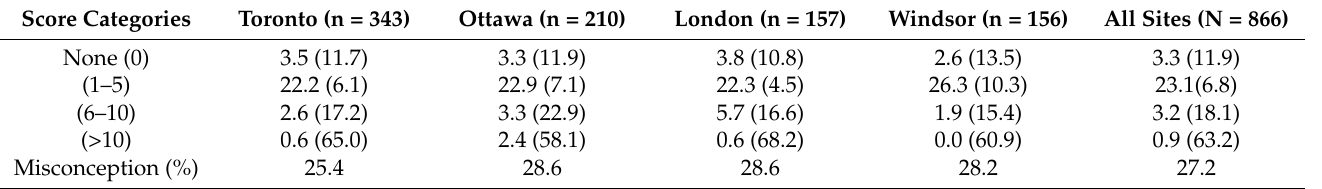
Table 2. Percentages of Participants with HIV Misconceptions versus those with HIV Knowledge across